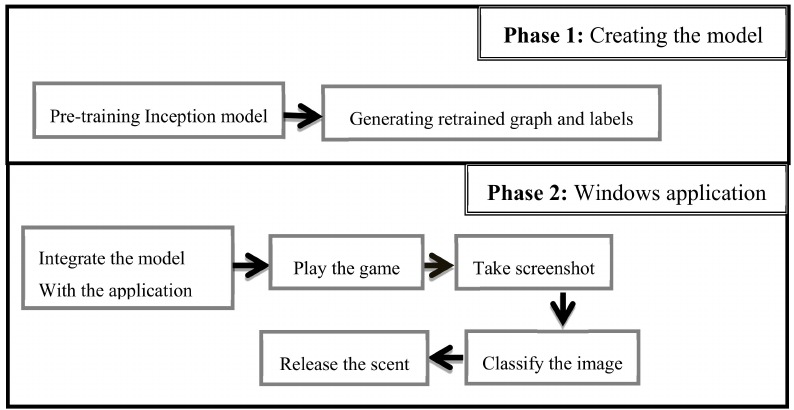
Figure 1. Framework of the